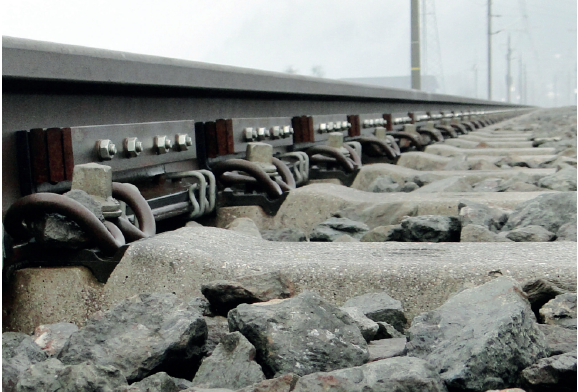
Figure 5. Rail absorber (VICON AMSA 60 VS, Schrey & Veit GmbH, Sprendlingen, Germany, reprinted with permission from Ref. [13], Copyright 2022, Schrey &Veit) consisting of a stack of alternating metal and plastic plates acting for the reduction of noise from vibrating rails, which are a further major sound emitter in addition to the rail wheels